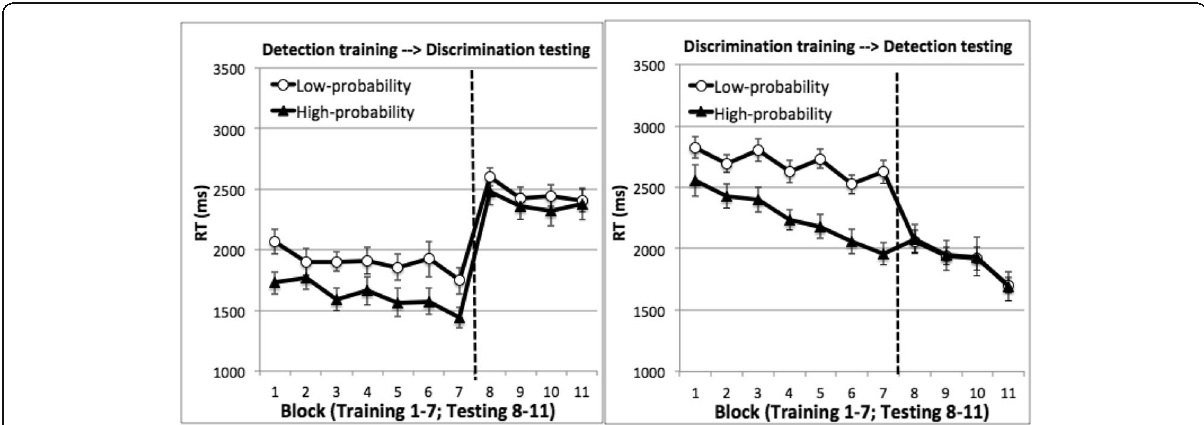
Fig. 3 Mean RT on target-present trials of Experiment 2. Left : Participants were trained in the detection task and tested in the discrimination task. Right : Participants were trained in the discrimination task and tested in the detection task. There were seven training blocks and four testing blocks. Error bars show ±1 S.E. of the